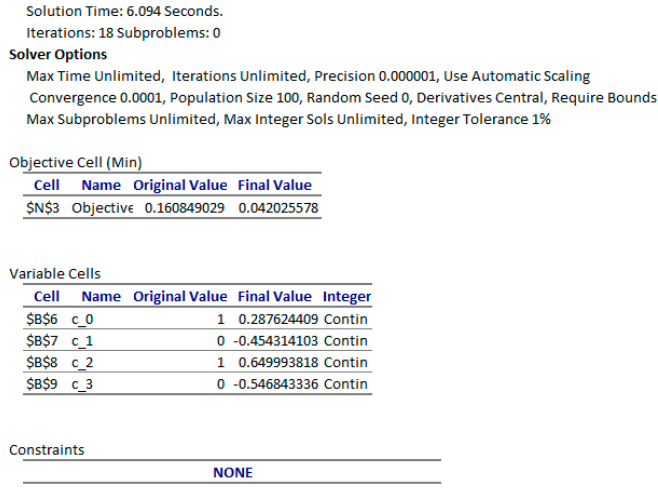
Figure 12. Answer Report for optimal control problem (12)–(15) using a different initial guess and yielding improved minimum.